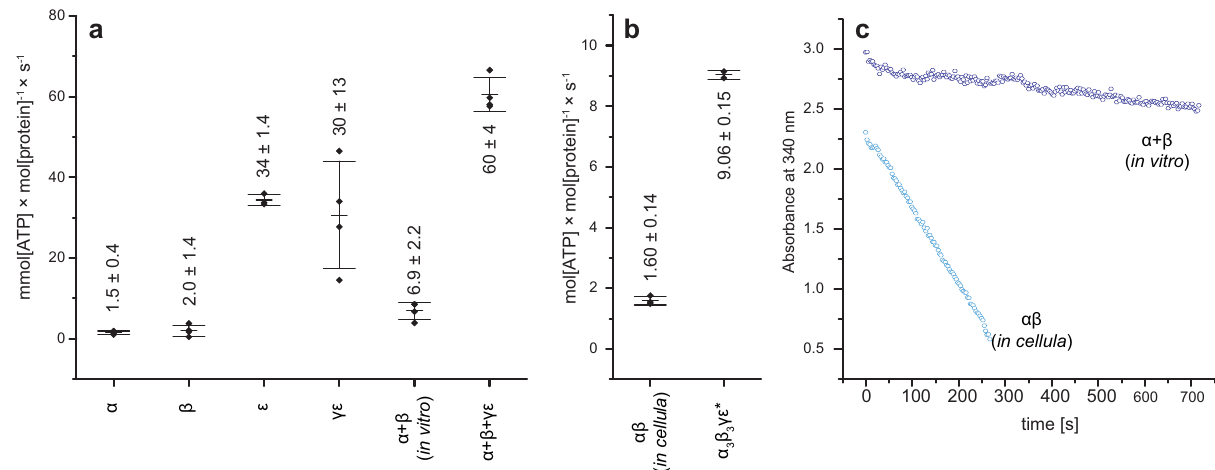
Fig. 9 ATP hydrolysis of isolated subunits and in vitro and in cellula assembled complexes. a Isolated α , β , ε , γε and in vitro assembled αβ and α 3 β 3 γε complexes. b In cellula αβ and α 3 β 3 γε * complexes. Data are presented as mean values with error bars showing the SD, with individual data superimposed. c Spectroscopic comparison of the decrease in absorbance at 340 nm per time [s] in the enzyme-coupled ATPase activity assay of the in vitro assembled αβ from isolated α and β (5.5 µ M each) relative to the in cellula produced αβ (0.5 µ M protein complex) in 100 µ L (100 mM TRIS, 100 mM maleic acid, 5 mM MgCl 2 , 3 mM phosphoenolpyruvate (PEP), 4 mM ATP, 0.5 mM NADH, 10 units L-lactate dehydrogenase (L-LDH), 10 units pyruvate kinase (PK), pH 7.5). In vitro data were collected in biological quadruplicates ( n = 4) except ε with three biological replicates ( n = 3) and in cellula data were collected in biological triplicates for αβ ( n = 3) and technical duplicates for α 3 β 3 γε * ( n = 2). Source data underlying Fig. 9a and b are provided as a Source Data fi